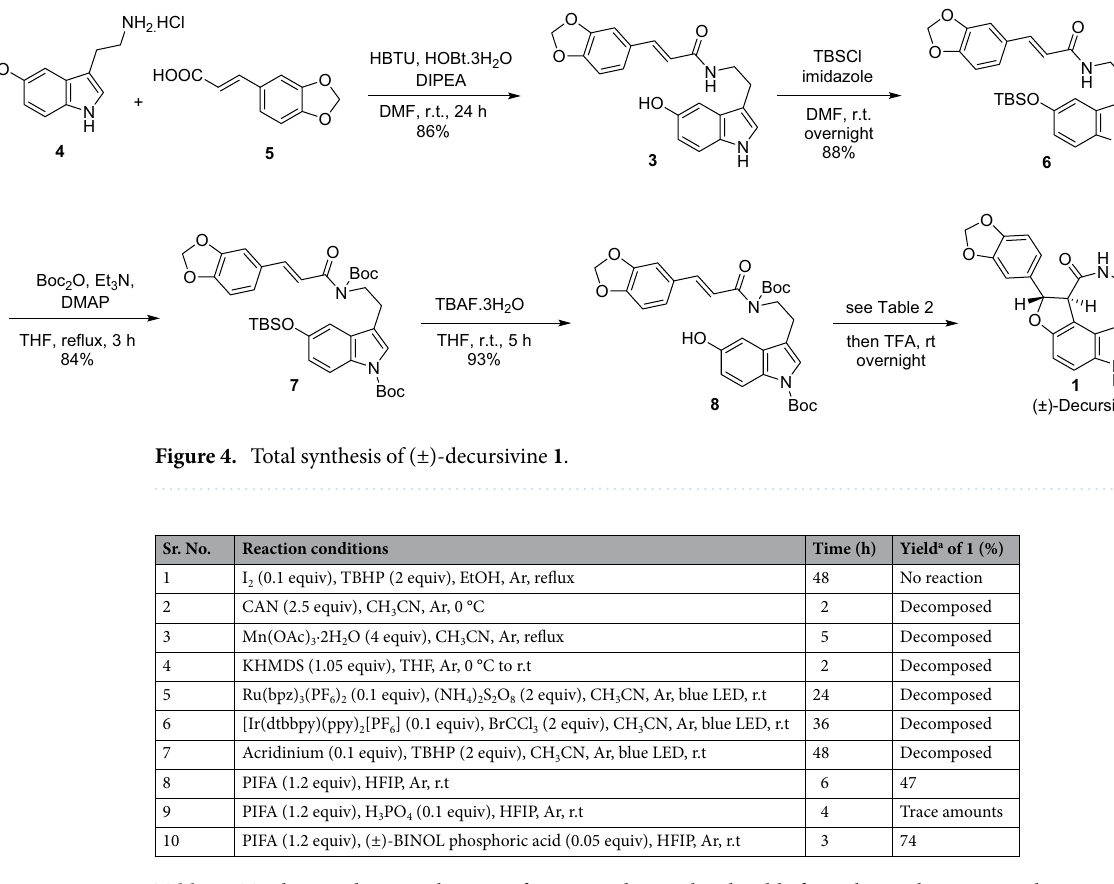
Table 2. Tandem oxidative cyclization of compound 8 . a Isolated yield after column chromatography.